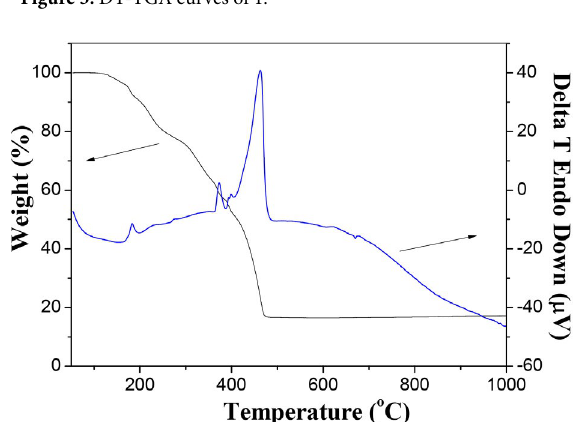
Figure 6. DT-TGA curves of 2